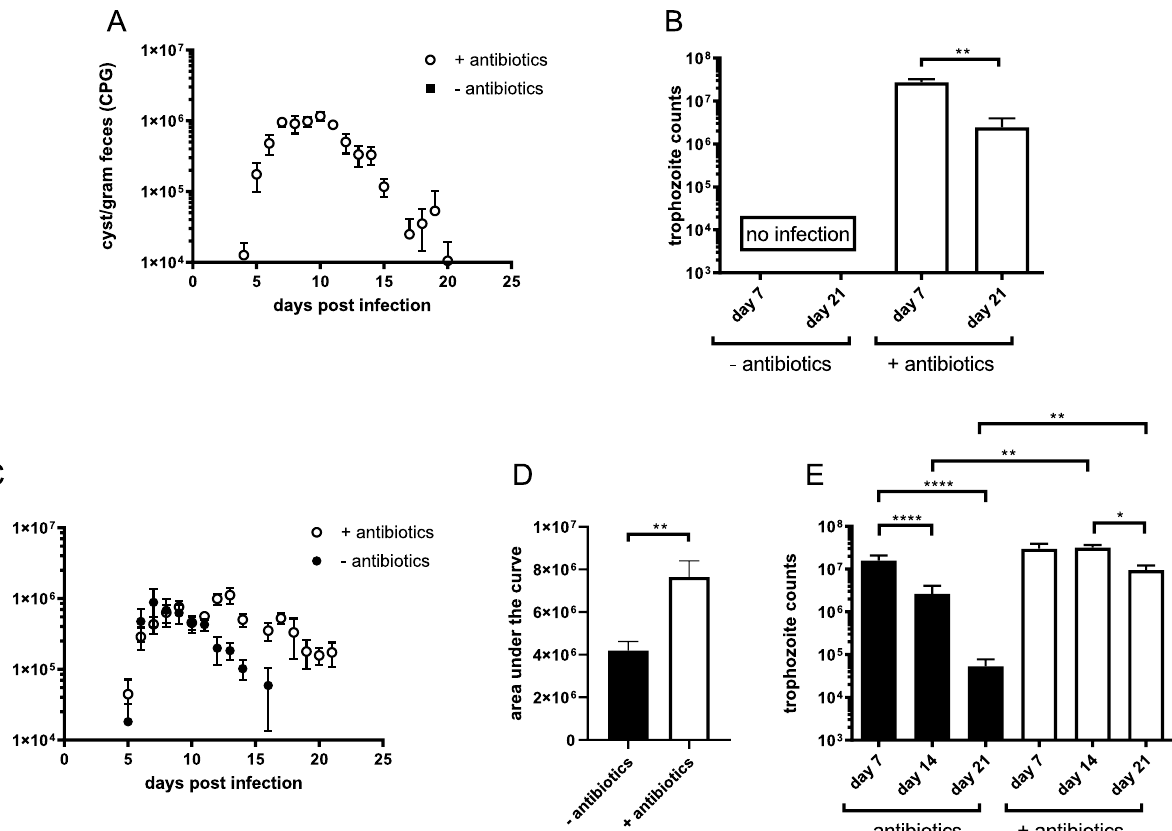
Figure 1. Dynamics of Giardia infections in mice following antibiotic treatment. ( A ) G. duodenalis cysts present in the feces of antibiotic-treated and untreated mice were monitored daily until day 21 p.i. Mean numbers of cysts per gram faeces obtained from 5 mice at every time point are depicted, with SEM as error bars. ( B ) G. duodenalis trophozoite numbers in the small intestine of antibiotic-treated C57Bl/6 mice at indicated time points. No trophozoites were detected in the untreated mice. ( C ) G. muris cysts present in the faeces of antibiotic-treated and untreated mice were monitored from day 4 p.i. until day 21 p.i. Mean numbers of cysts per gram faeces obtained from 5 mice at every time point are depicted, with SEM as error bars. ( D ) Area under the curve analysis of cyst counts between antibiotic treated and untreated C57Bl/6 mice infected with G. muris ( E ) G. muris trophozoite numbers in the small intestine of antibiotic-treated and untreated C57Bl/6 mice at indicated time points. (*p ≤ 0.05, **p ≤ 0.01, ***p ≤ 0.001, ****p ≤